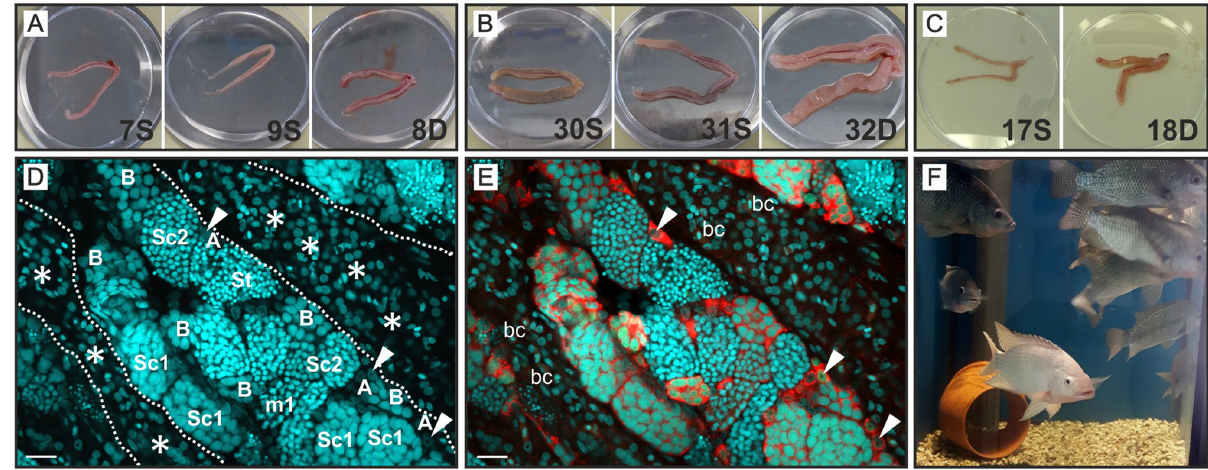
Fig 1. Pictures of testes used for RNA-Seq in this study as well as example images for the testis morphology and a fish tank with Nile tilapia in stable hierarchy. (A) , (B) and (C) Pictures of testes from subordinate (S) and dominant (D) males used in this study (according to Table 4). (A) Pictures of family 1 (males IDs 7S, 9S and 8D). (B) Pictures of family 3 (males IDs 30S, 31S and 32D). (C) Pictures of family 2 (males IDs 17S and 18D). (D) , (E) Details of testis morphology from a dominant animal (33-month-old male, GSI 0,26; not part of the RNA-Seq experiment) to illustrate morphology of a well-developed testis. (D) Draq5 1 staining (cyan) of cell nuclei. A dotted white line labels position of the wall of seminiferous tubules. Asterisks label interstitial compartment including many Leydig cells (show typical cell nuclei with 5 μ m in diameter). Germ line cells inside of a tubule were labeled according to their developmental stage: A—type A spermatogonia, B—type B spermatogonia, Sc1 –primary spermatocytes, m1 –Sc1 during first meiotic division, Sc2 –secondary spermatocytes, St—spermatids. A white triangle marks the nucleus of selected type A spermatogonia additionally and these triangles were also inserted in (E). The classification of germ line is based on morphological criteria such as cell nucleus diameter and number of cells per cyst. Single cells with largest nuclear diameters of 8 μ m or above inside of seminiferous tubules correspond to type A spermatogonia. Further advanced stages (type B spermatogonia and spermatocytes) have a smaller nuclear diameter then type A spermatogonia and show an increasing number of cells with ongoing generations inside of one synchronously developing germ cell cyst. Spermatids can be easily identified by their high number per cyst and their small nuclear diameter. Further details about staging of germ cells and histological methods are described in the Methods section. (E) In addition to the nuclear Draq5 1 staining (cyan), Vasa protein caused red fluorescence and Pcna protein caused green fluorescence (most of the green fluorescent cells appear in turquoise because of the overlay with a strong Draq5 1 signal) is shown. The undifferentiated type A spermatogonia have the highest levels of the germ line marker Vasa which is reduced during the further differentiation of germ line cells until onset of meiosis. Pcna is expressed in cells at S-phase of the cell cycle. Blood cells (bc) can be identified in the red/green-fluorescence-channel overlay by their typical brownish appearance within the interstitial compartment. (F) Snapshot from a 540 L tank with a long-term stable hierarchy. A dominant white-appearing male holds a territory around the orange tube and at the bottom of the tank. Darker appearing subordinates and females stay outside of its territory. Scale bars in (D) and (E): 20 μ m. Diameter of Petri dishes shown in (A)–(C): 90